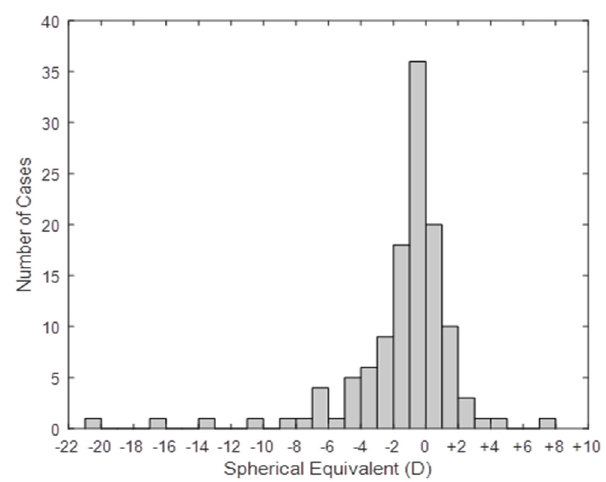
Figure 3. Spherical Equivalent refractive error distribution, for the present population ( n = 122).